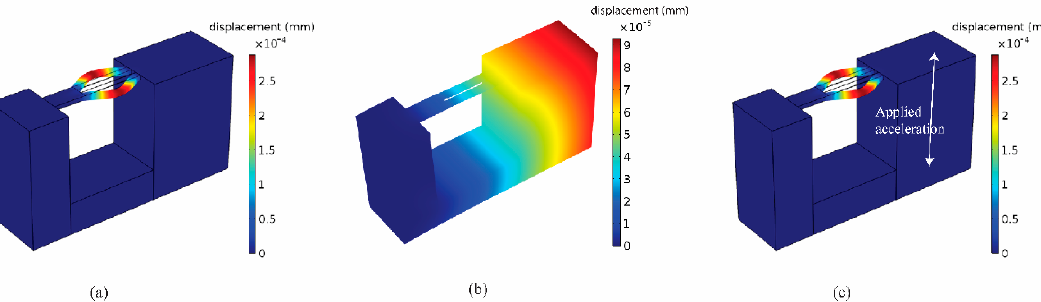
Figure 7. ( a ) The anti-phase resonant mode of the DETF indicating the resonance driven via the external circuit. ( b ) The fundamental resonant mode of the entire accelerometer at the first resonant frequency of 10 kHz. ( c ) The anti-phase resonant mode of the DETF under di ff erent applied accelerations where the resonant frequency of the DETF was shifted due to the applied